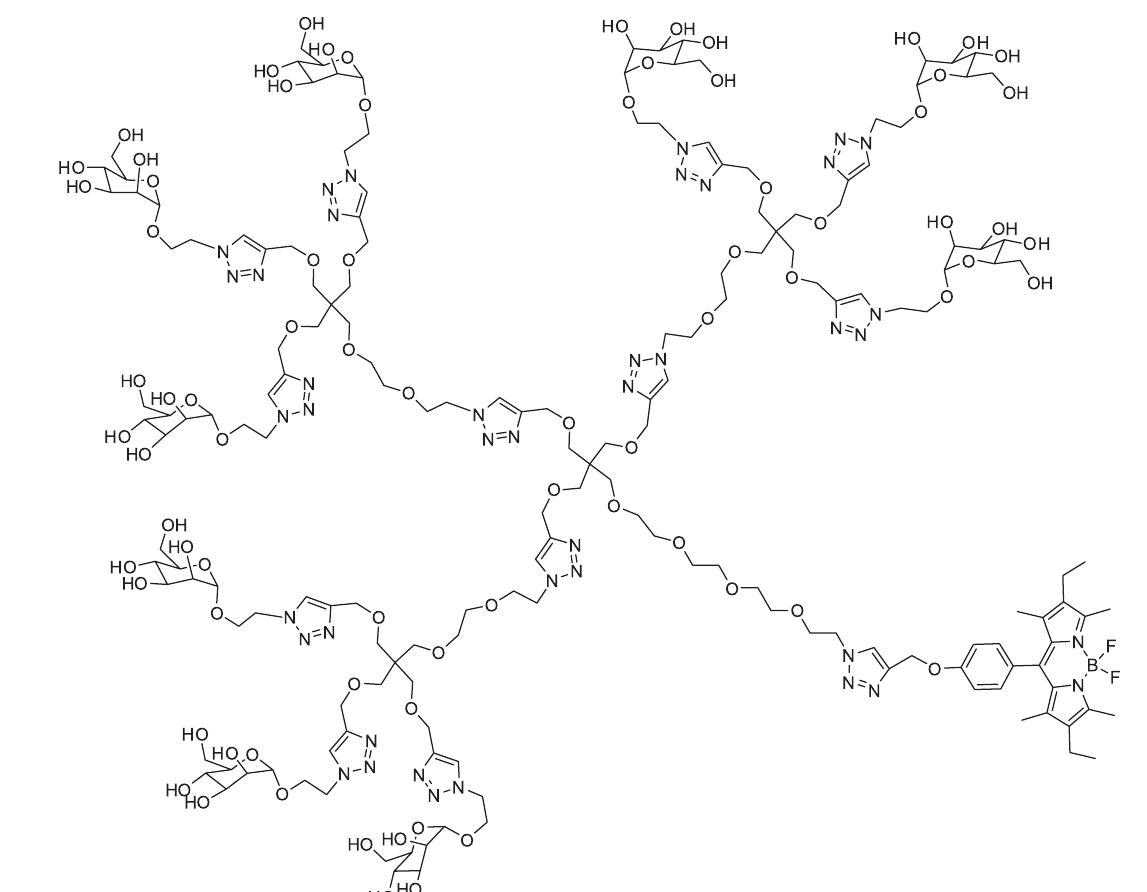
FIGURE 8 - Mannosyl nonavalent dendron fluorescence labeled with